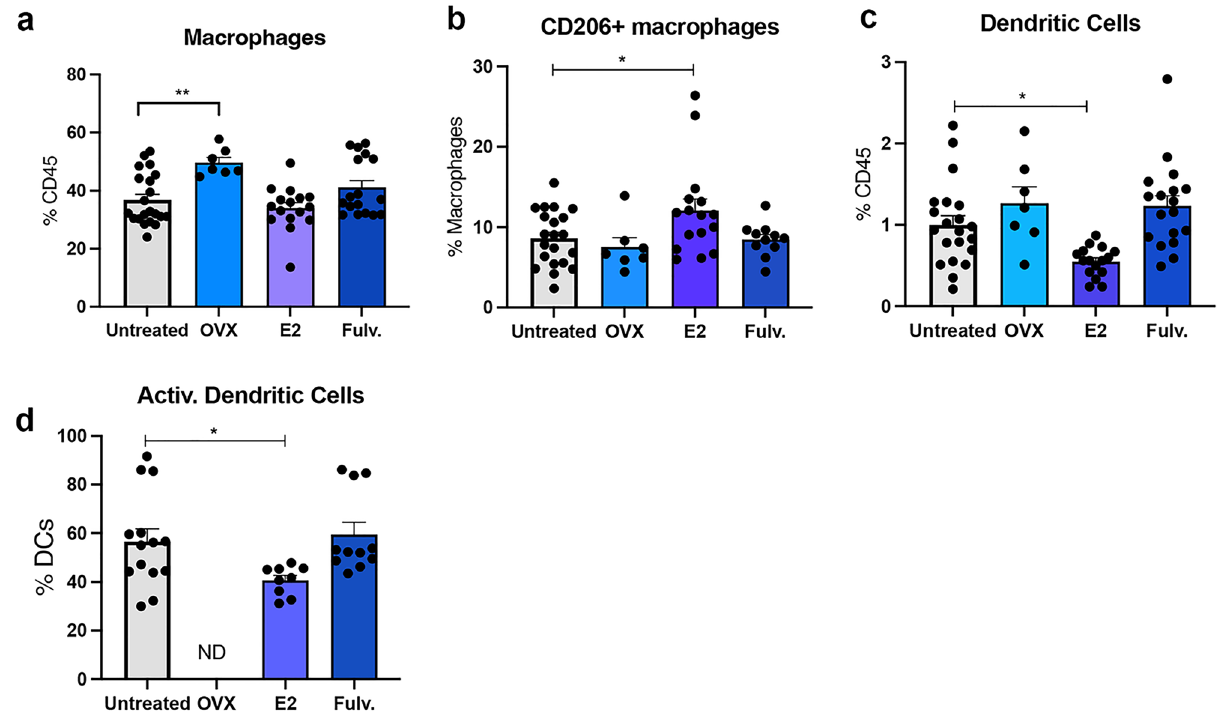
Figure 3. Effects of estrogen, oophorectomy and fulvestrant on the mammary lymph node immune cells. Mice were either untreated, ovariectomised (Ooph) or treated for 6 weeks with estrogen (E2) or Fulvestrant (Fulv). ( a ) macrophages, ( b ) CD206 + macrophages, ( c ) dendritic cells ( d ) activated (CD86 +) dendritic cells. Results are expressed percentage of immune cells (mean ± SEM). n = 7–21 mice/group. Data was analysed using a Turkey multiple comparisons one-way ANOVA if confirmed Gaussian distribution, or Kruskal–Wallis multiple comparisons 1-way ANOVA if non-Gaussian. Statistically significant results are denoted with *p < 0.05, **p <